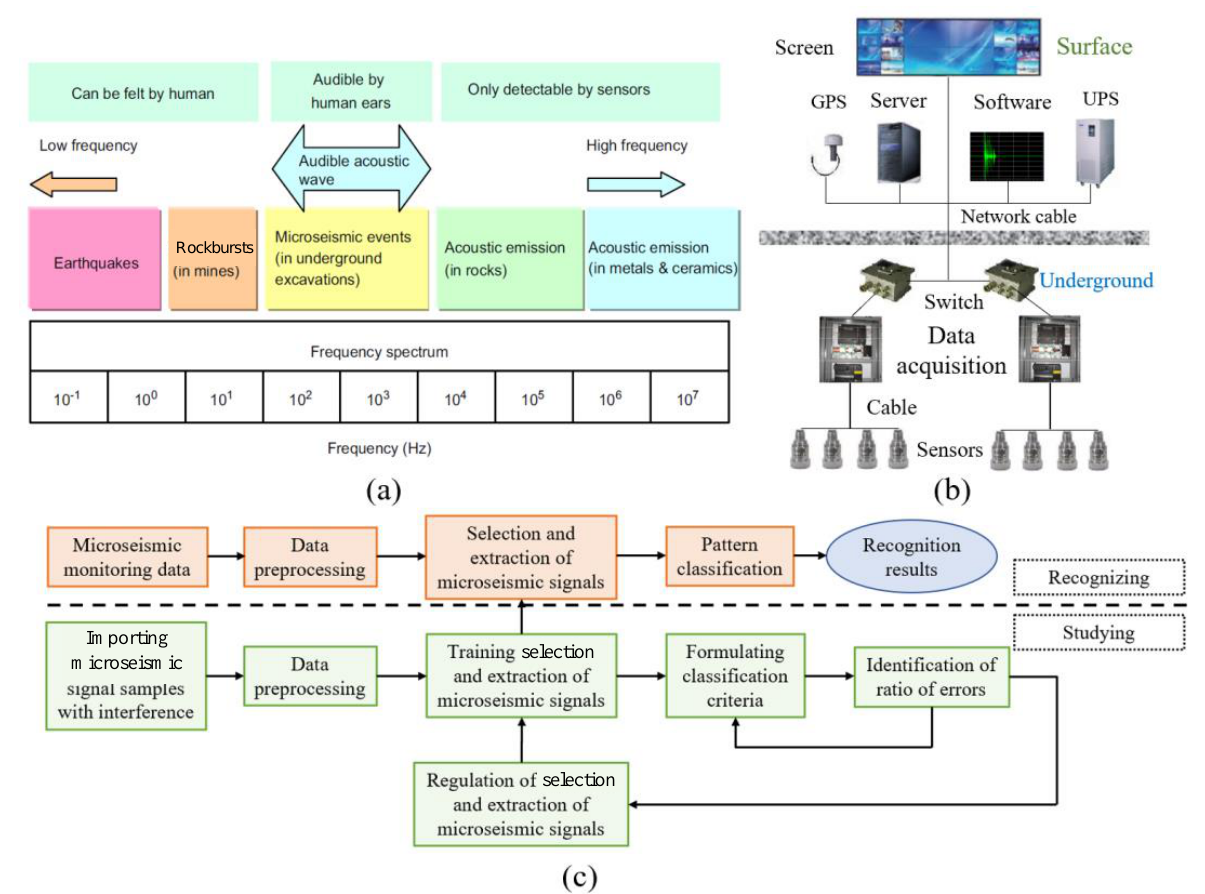
Figure 4. In situ monitoring for rockburst: ( a ) seismic motion wave frequency spectrum and field of application of AE/MS techniques (from [67]), ( b ) structure of a microseismic monitoring system in a mine (modified from [69]), ( c ) pattern recognition for microseismic signals (from [70]).